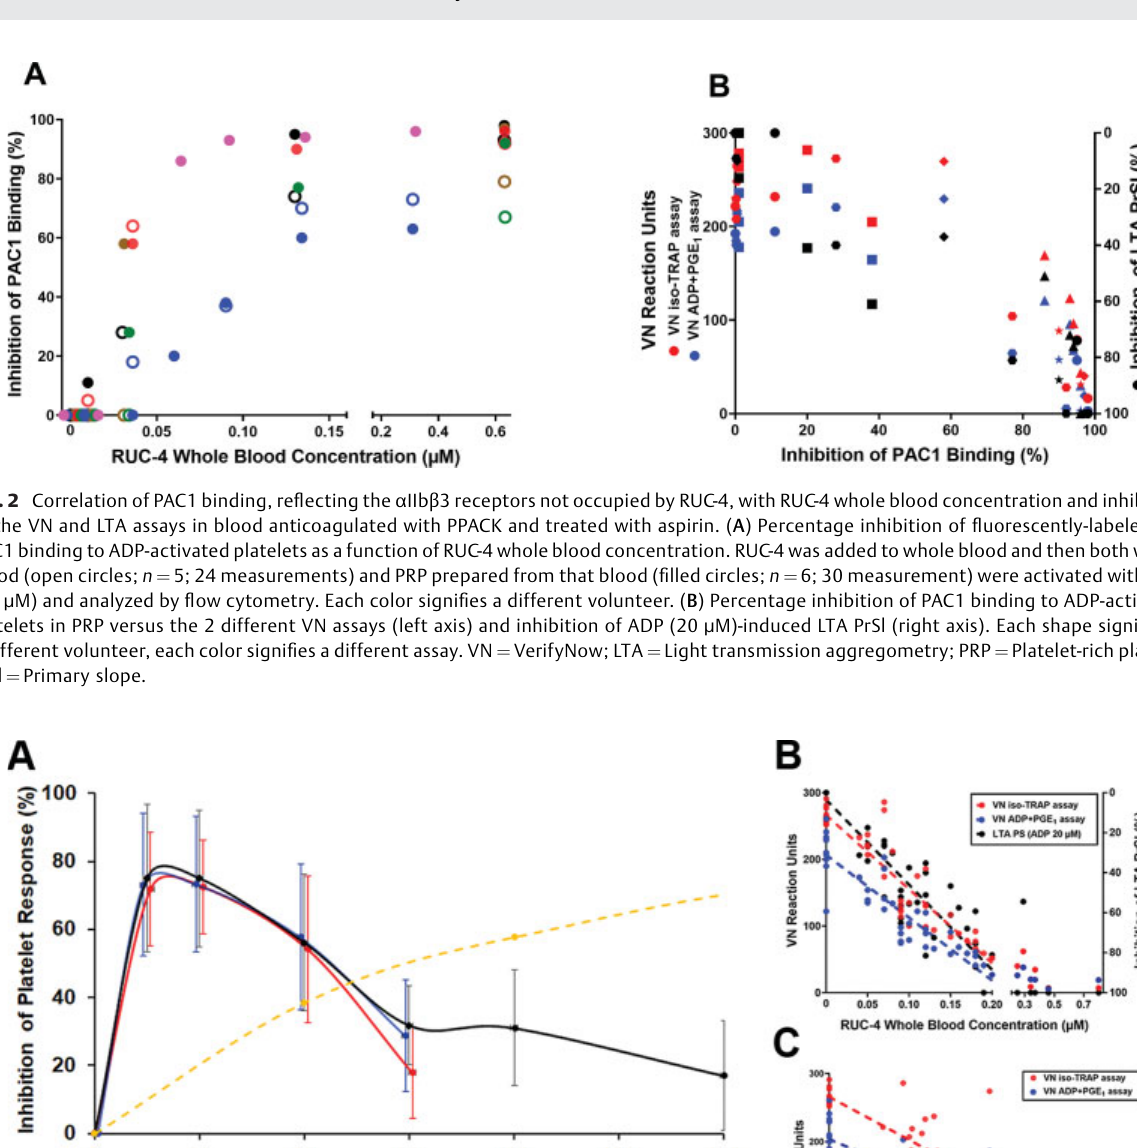
VN iso-TRAP Assay Reaction Units Correlate with LTA- measured Platelet Aggregation in Blood from Individuals Treated with RUC-4